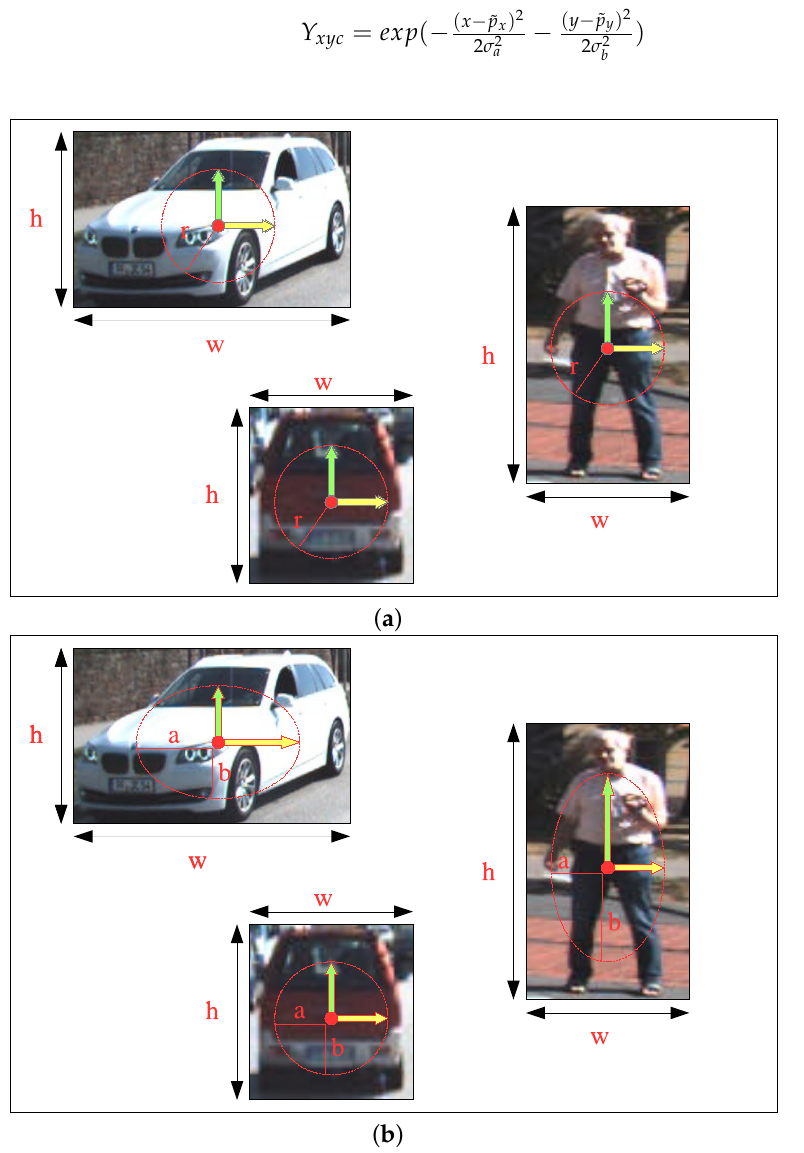
Figure 3. Comparison between two Gaussian filters. ( a ) Traditional Gaussian filter. ( b ) Self-adapting ellipse Gaussian filter